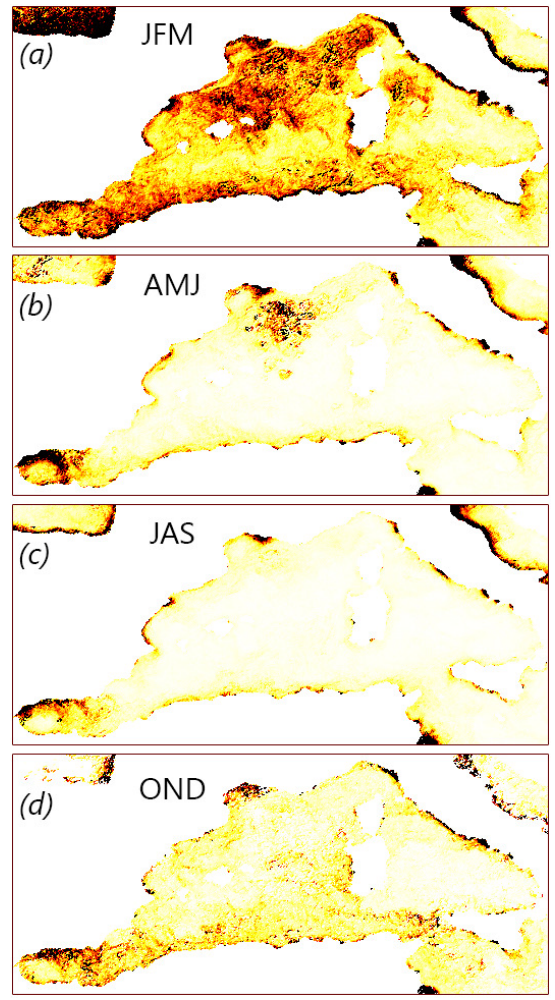
Figure 4. Seasonally averaged gradient of Chl-a in 2009 Unlike thermal fronts (Figure 3), during winter and spring the high gradients of Chl-a mostly correspond to edges of the seasonal phytoplankton bloom rather than to surface circulation features (Figures 4(a)-(b)). Noteworthy that in the first half of year, the Northern Current is manifested by the relatively low values of Chl-a gradient. In spring, we note that the propagation of Atlantic water along the periphery of the Alboran Eddy is seen not only in the field of SST, but also in Chl-a (Figure 4(b)). In summer, high Chl-a gradients are observed only in the near-coastal areas (Figure 4(c)). In autumn, there are slightly increased contrasts of Chl-a along the southern